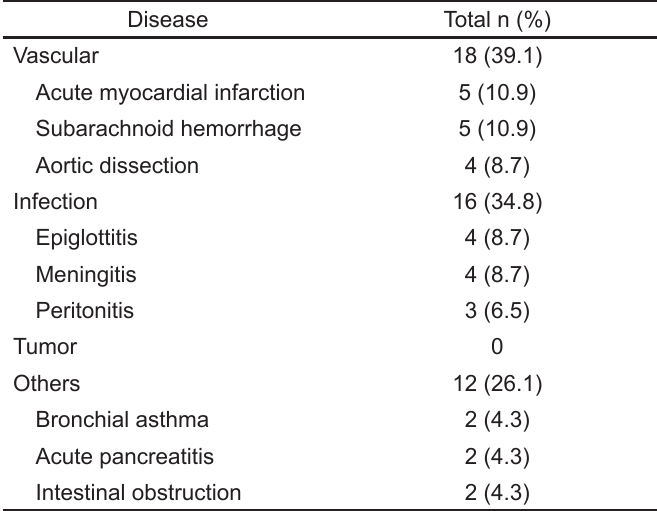
Table 3. Non-trauma related final diagnosis